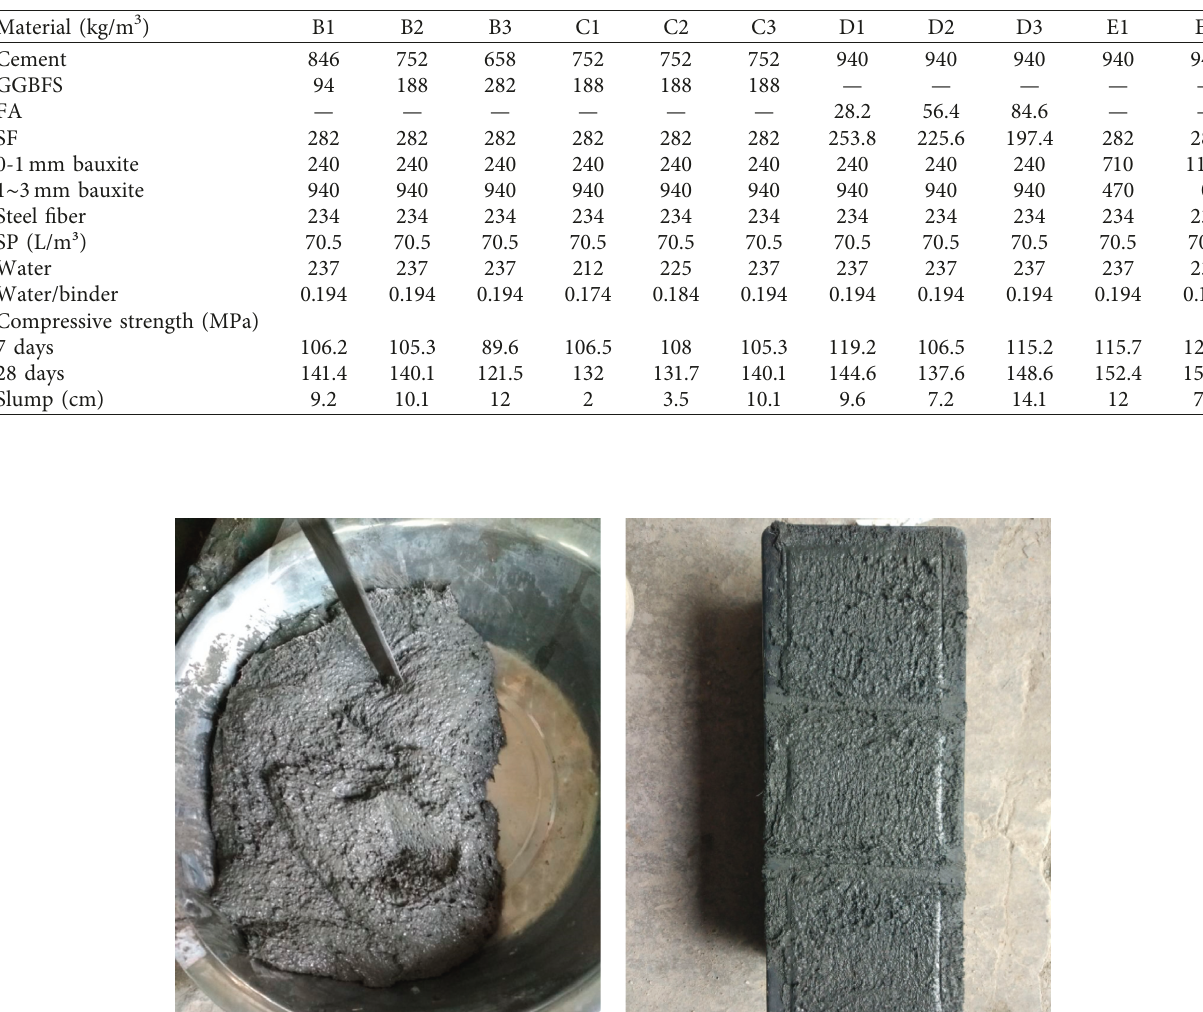
Table 3: Composition of the mixtures and the test